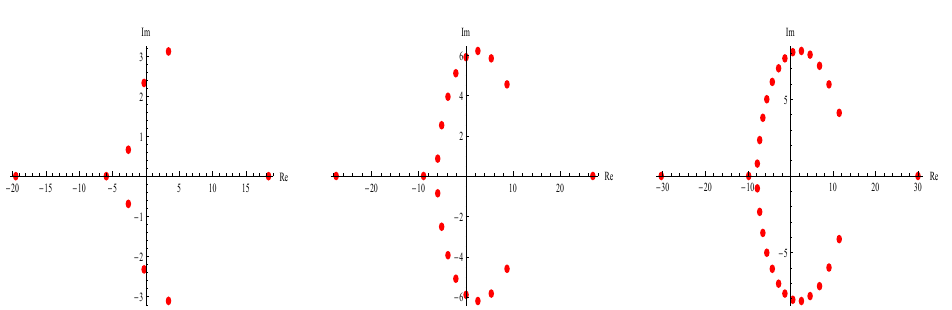
Figure 1. Approximate root of C B n ,0.9 ( x ,5 ) for n = 10,20,30.